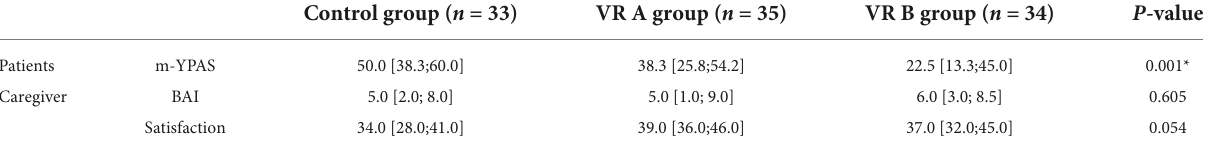
TABLE 2 Preoperative anxiety, compliance during induction of anesthesia, caregivers’ distress, and